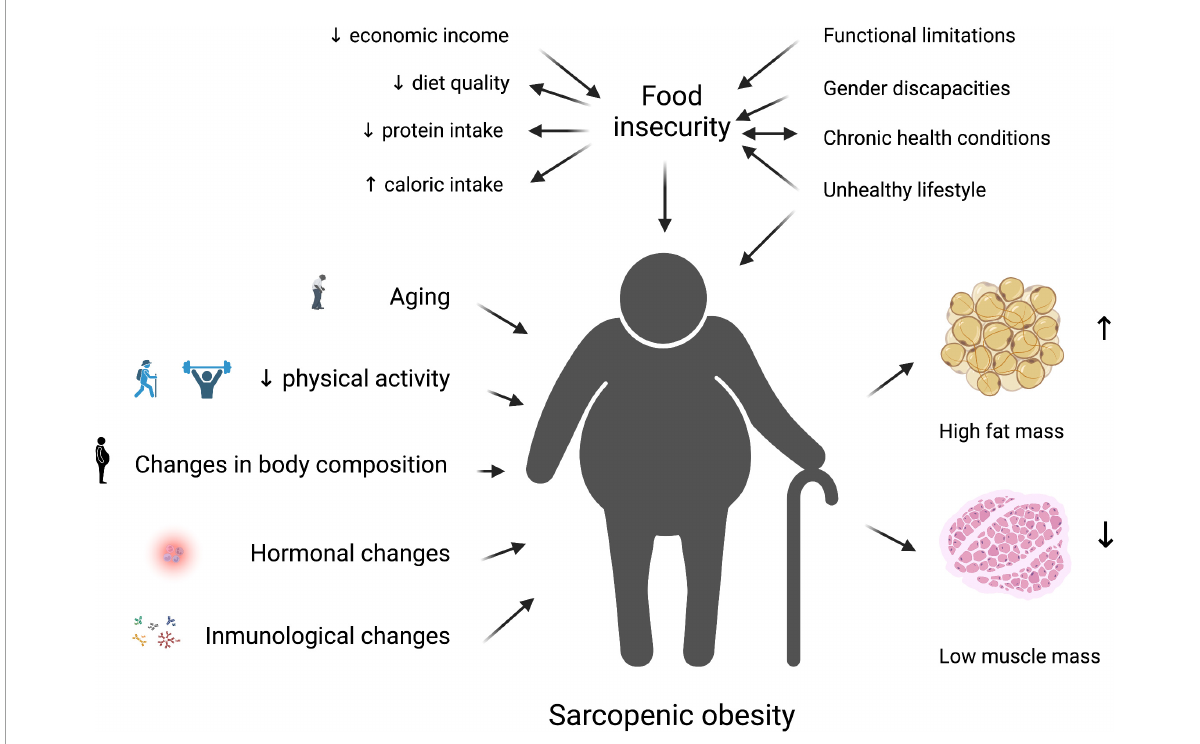
FIGURE1 The interrelation between food insecurity and sarcopenic obesity in older adults is related to low economic income, impacting a low-quality diet with a small protein intake with a high energy offer. This scenario is worsened by unhealthy lifestyles and the presence of comorbidities, and body composition alteration due to hormonal and immunological changes, resulting in low muscle mass and high-fat mass. This image was created using